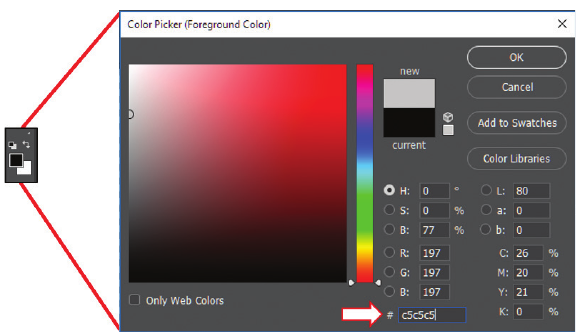
Figure 17. Colour tool with open colour selection panel. High- light the dialogue box where you can write the code for each colour you want to get.